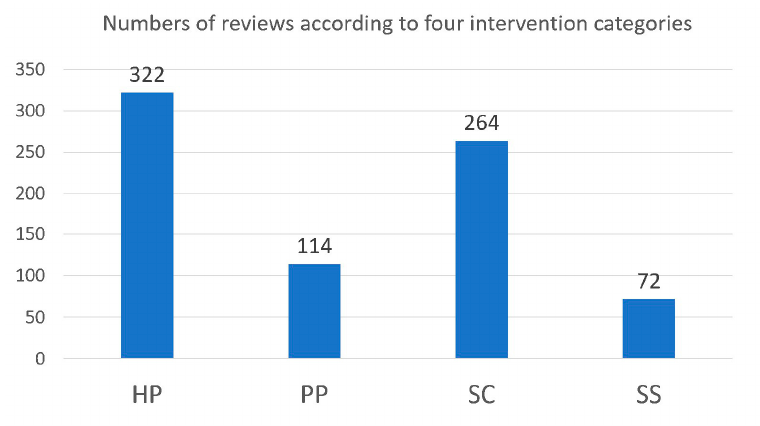
Figure 3. Number of reviews based on four intervention categories.